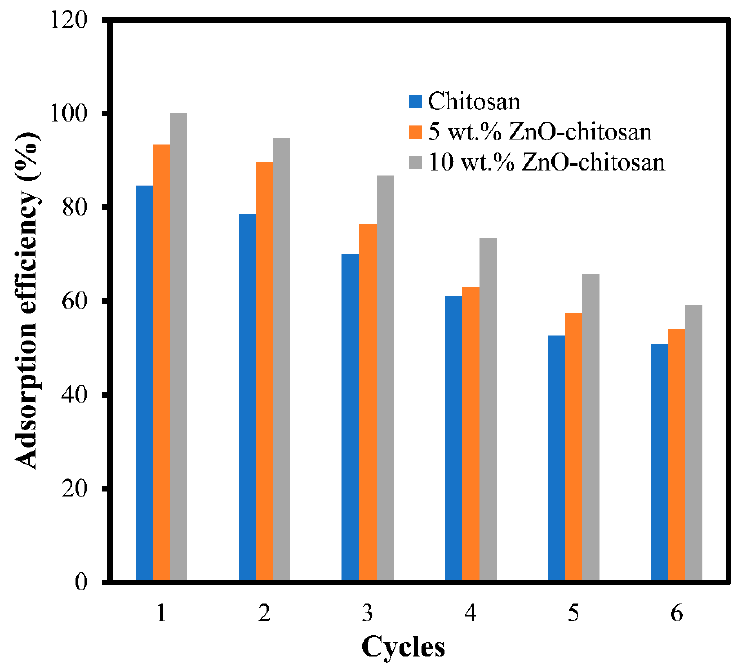
Figure 8. Reusability of chitosan and composites for the dye adsorption.